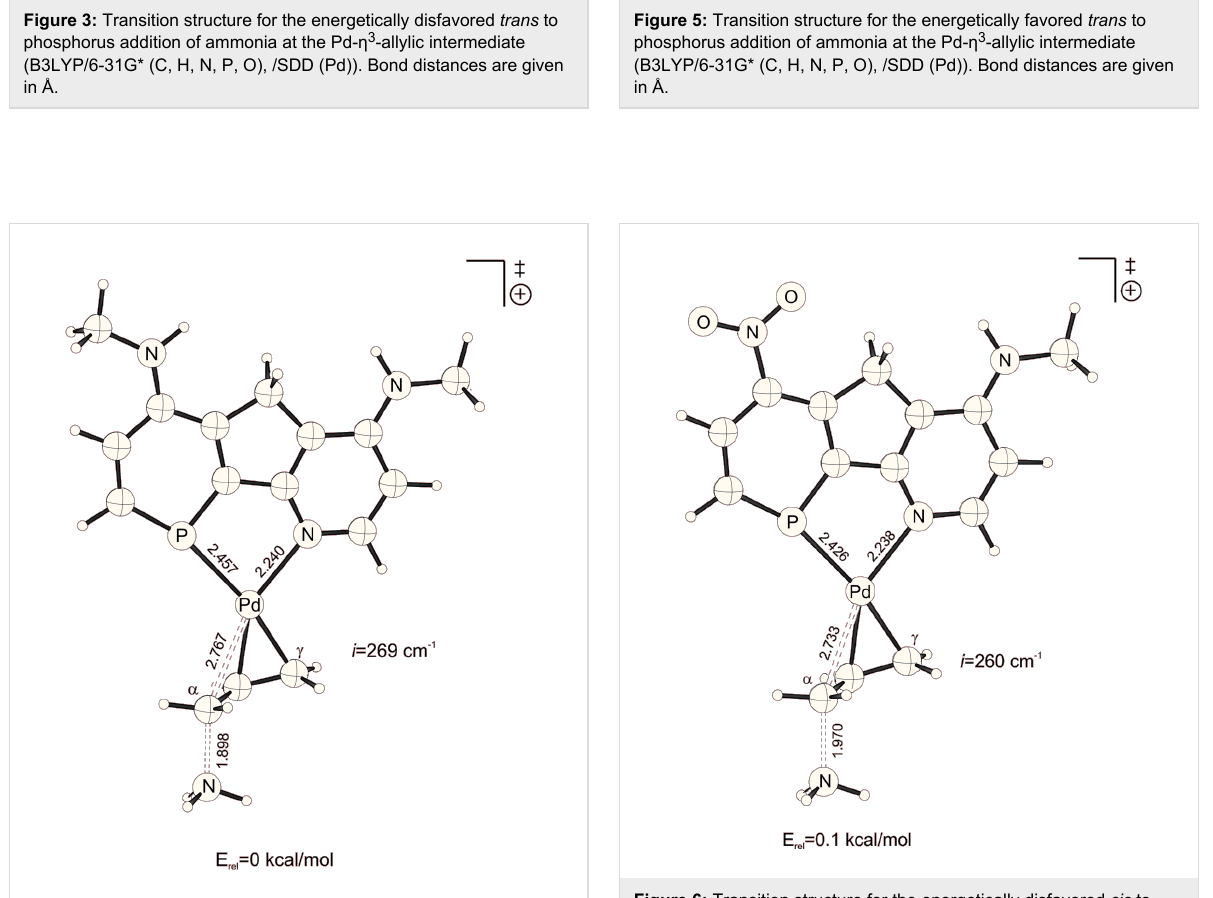
Figure 6: Transition structure for the energetically disfavored cis to phosphorus addition of ammonia at the Pd-η 3 -allylic intermediate (B3LYP/6-31G* (C, H, N, P, O), /SDD (Pd)). Bond distances are given in